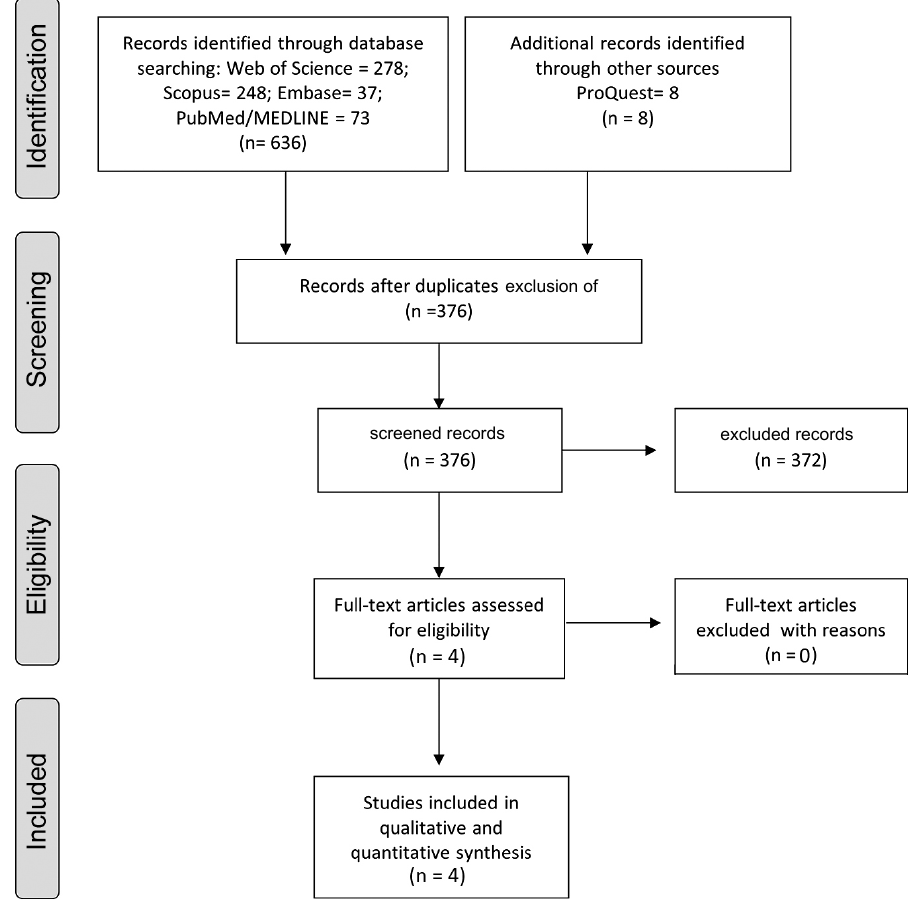
Figure 2- Prisma Flow